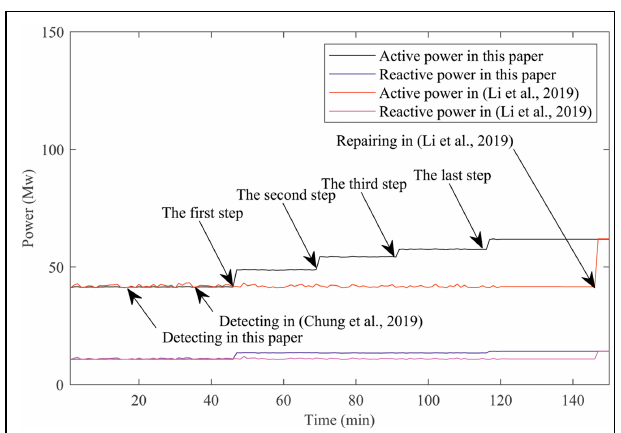
FIGURE 4 | Repaired active power and reactive power of ICPPSs under hybrid